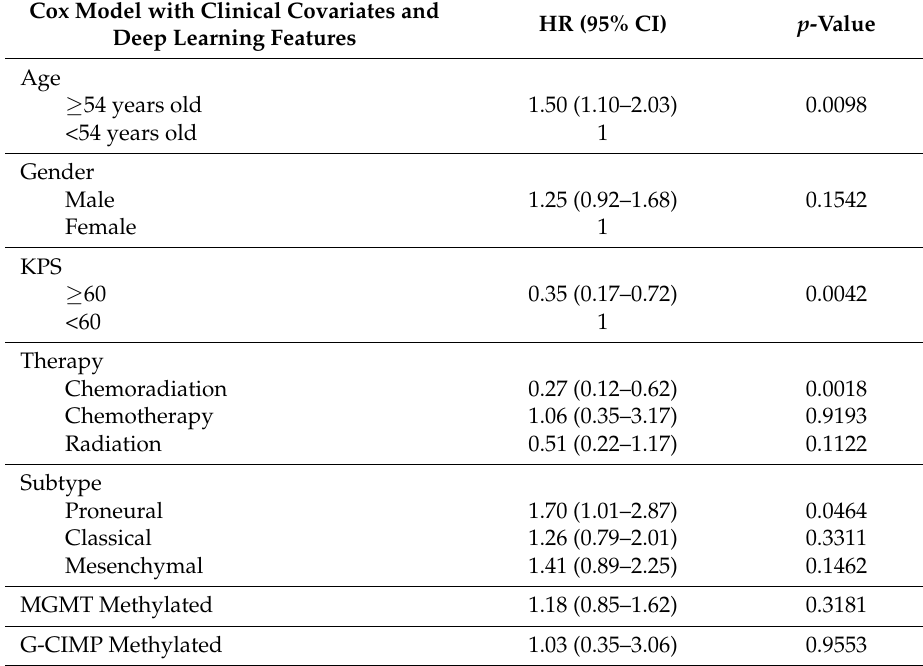
Table 3. Combined multivariate Cox proportional hazard model including clinical covariates and deep learning network node covariates to predict overall survival ( p -value < 0.0001). The hazard ratios (HR) and 95% confidence intervals (95% CI) are listed with corresponding p